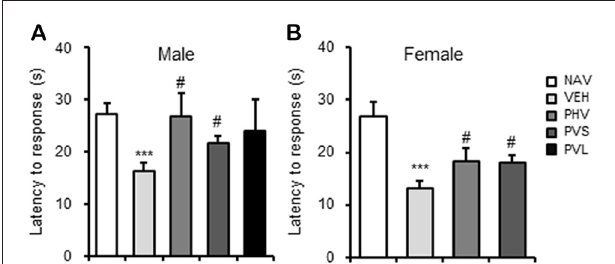
FIGURE 3 | HRW administration reversed the hyperpathia in VPA-exposed mice offspring. HRW administration significantly reversed the maternal VPA exposure-induced decrease of the latency to response of both male (A) and female (B) mice offspring in the HPT. ∗∗∗ P < 0.005 compared with the saline-injected group (NAV); # P < 0.05 compared with the VPA-exposed group (VEH; n = 6–10 per group).